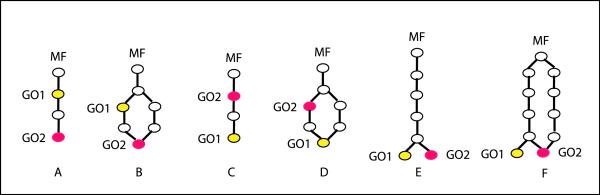
A schematic representation of possible GO term relationships: A: GO1 is a "parent" of GO2 in a single path relationship. B: GO1 is a "parent" of GO2 in a multiple path relationship. C: GO1 is a "child" of GO2 in a single path relationship. D: GO1 is a "child" of GO2 in a multiple path relationship. E: GO1 and GO2 are "siblings" in a single path relationship. F: GO1 and GO2 are "siblings" in a multiple path relationship. MF denotes the molecular function node (root).